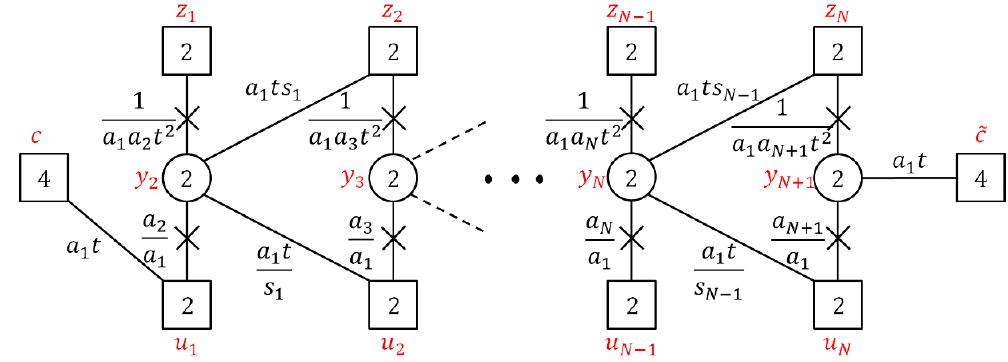
Figure 11 . A quiver diagram of the IR theory one (cid:12)nds after closing the minimal puncture by giving a vev to the operator f M 2 . The squares and circles denote SU( n ) global and gauge symmetries, 1 respectively, where n is the number inside. The (cid:12)elds denoted by the vertical lines have R-charge 0, the (cid:13)ip (cid:12)elds have R-charge 2 and the rest have R-charge 1. a i , s j and the two SU(4)’s are related to the internal symmetries that arise from 6 d . In red we write the symmetries associated fugacities, and in black we write the charges of each (cid:12)eld. The X ’s denote as usual (cid:13)ip (cid:12)elds. We emphasize that the six additional (cid:13)ip (cid:12)elds charged under c and c were removed. As always, each closed loop e of (cid:12)elds has a superpotential term turned on for